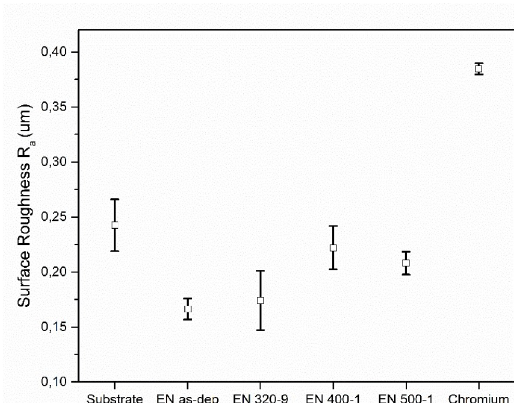
Figure 3. Average surface roughness for Ni-P and hard chromium coatings.